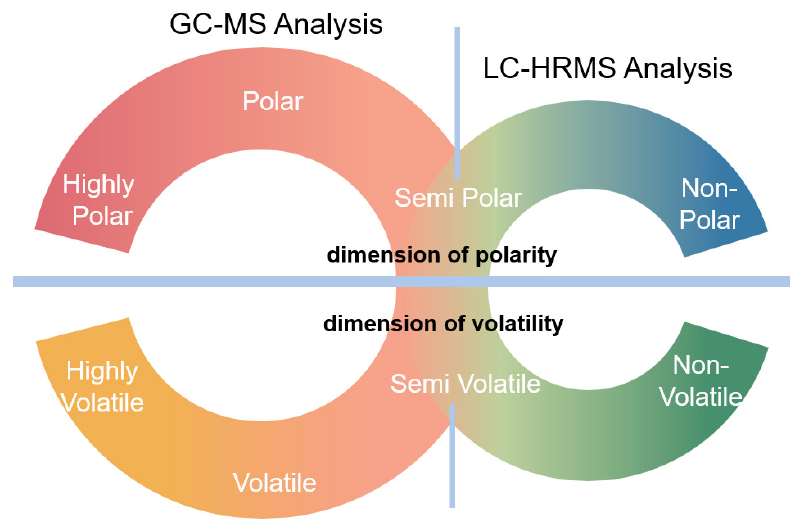
Figure 1. Chemical space which the NTA methods were developed to cover.